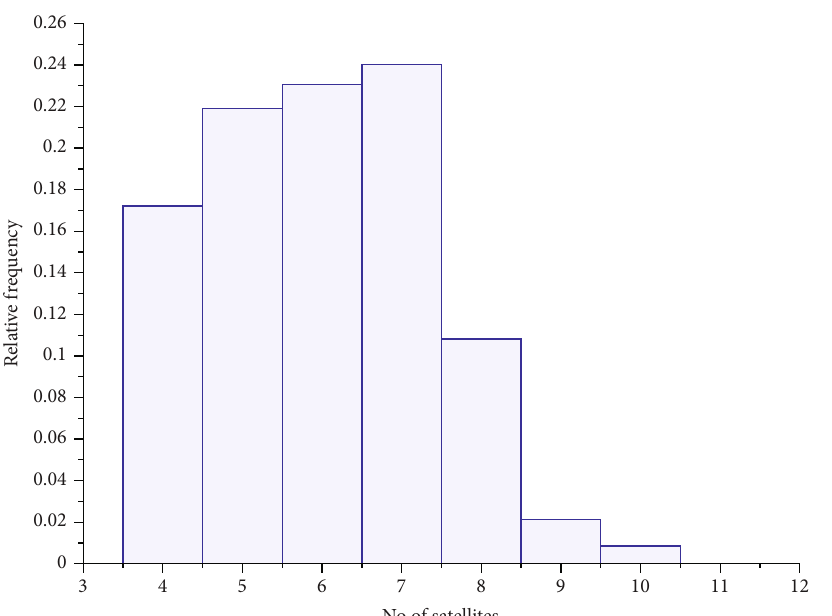
Figure 15: Normalized histogram of the number of satellites used for position, velocity, and time calculation.